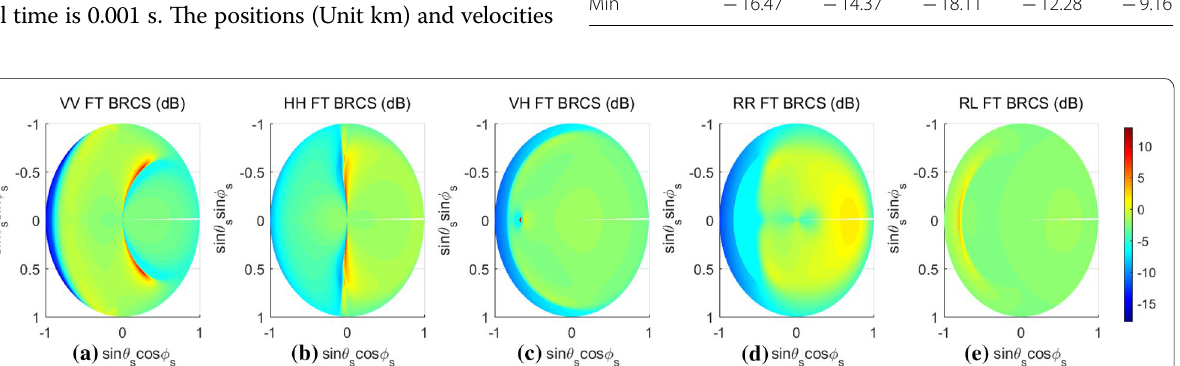
1 °C) to thawn state (1 °C) at linear polarization (VV, HH and VH) and −